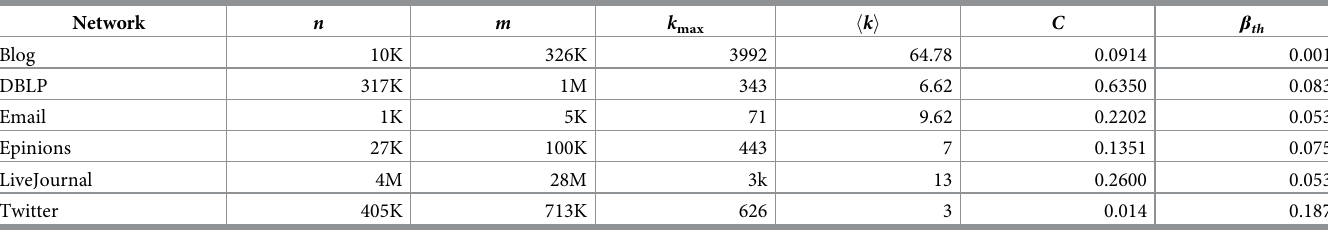
Table 1. The statistical properties of the six empirical networks a